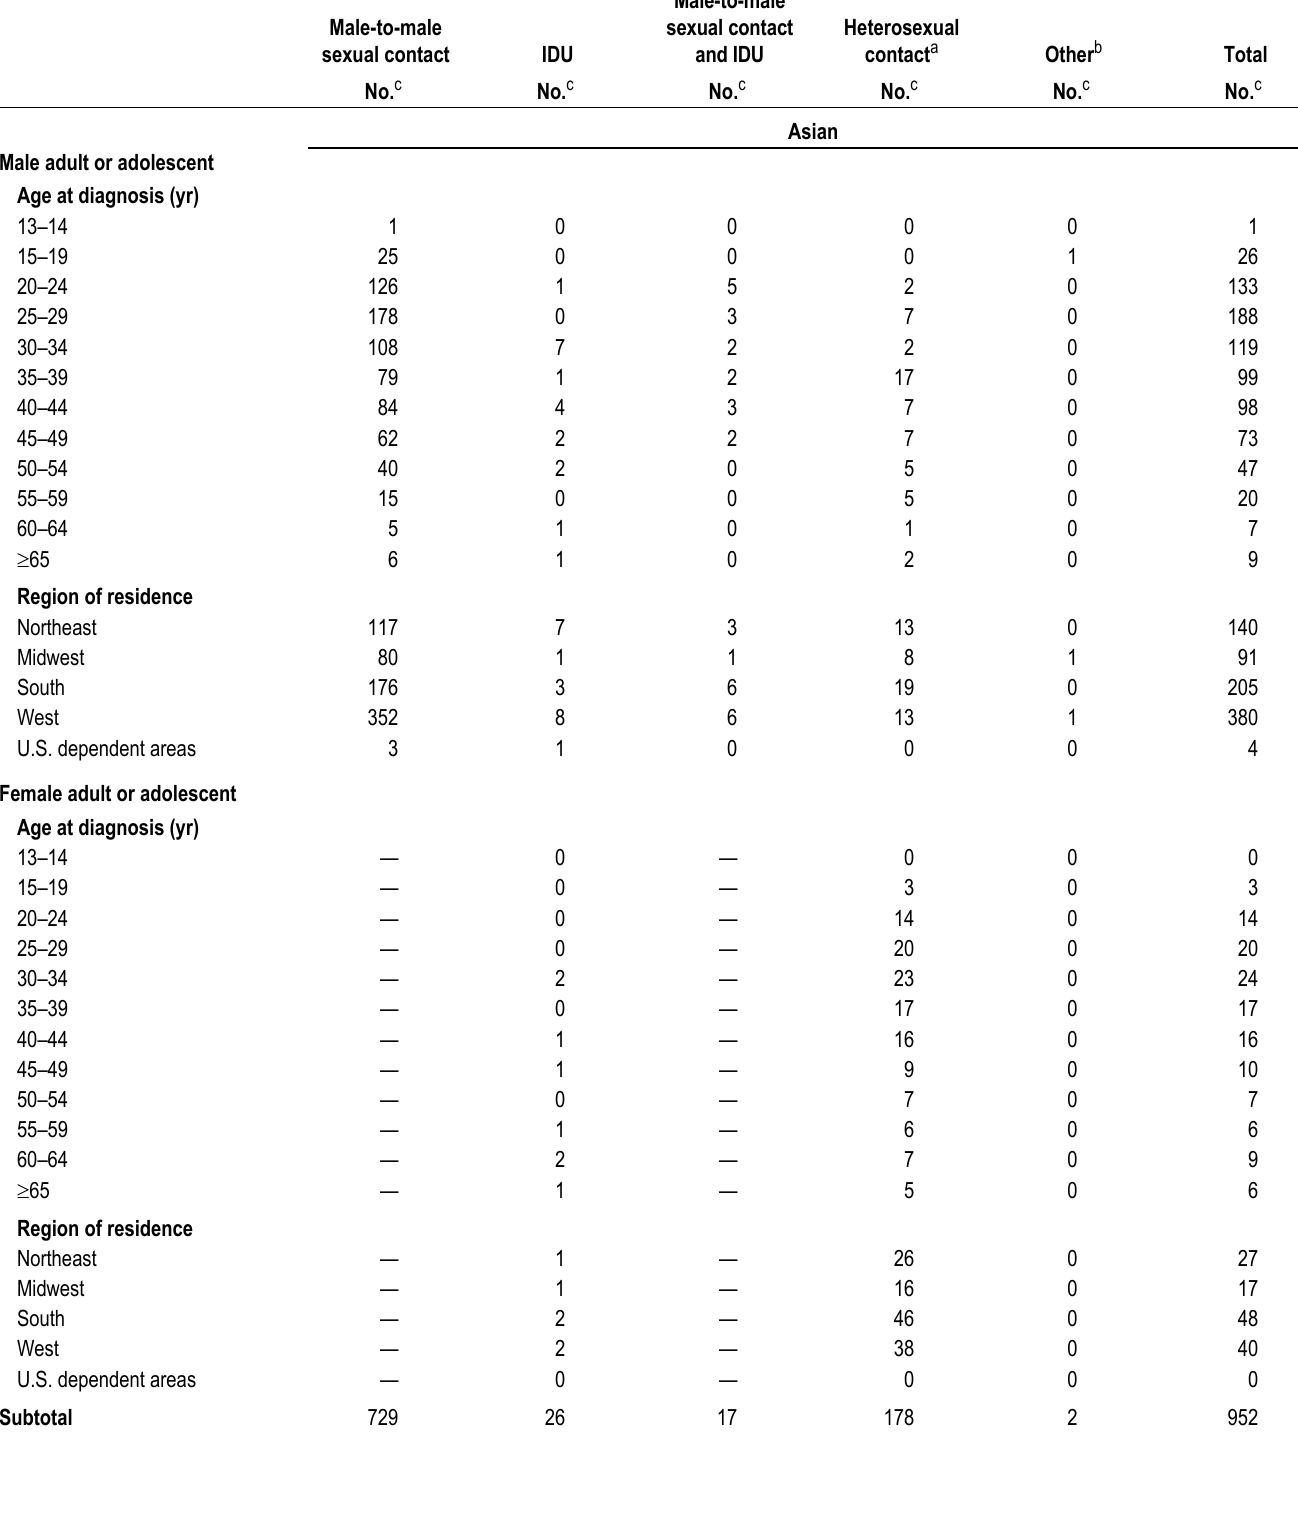
Table 5b. Diagnoses of HIV infection, by transmission category, race/ethnicity, and selected characteristics, 2015—United States and 6 dependent areas